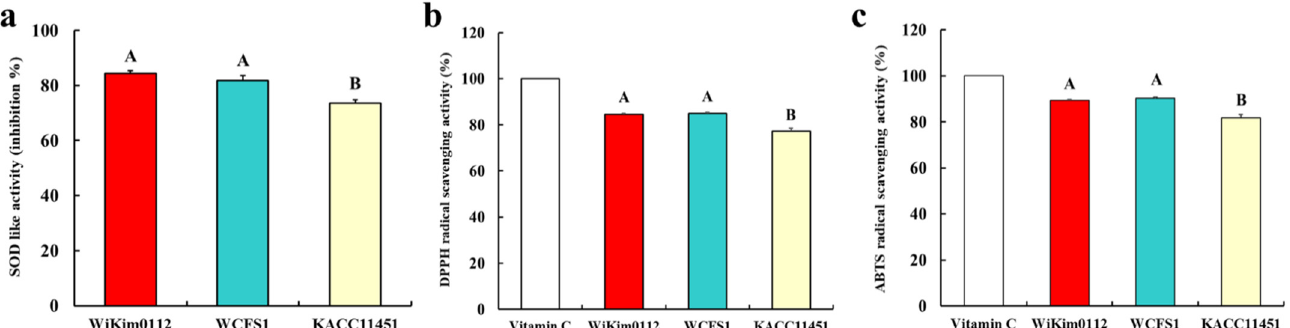
Figure 3. Antioxidative activities of Lpb. plantarum Wikim0112, WCFS1, and KACC11451. ( a ) Superoxide dismutase (SOD)-like activity, ( b ) 2,2-diphenyl-1-picryl-hydrazyl (DPPH), and ( c ) 2-azino-bis(3-Ethylbenzothiazoline-6-Sulfonic Acid) (ABTS) scavenging activities were estimated. As a positive control, 0.5% L-ascorbic acid was used with the same amount as the sample. The values represent the mean ± SD (n = 3). Different letters represent significant difference ( p < 0.5).